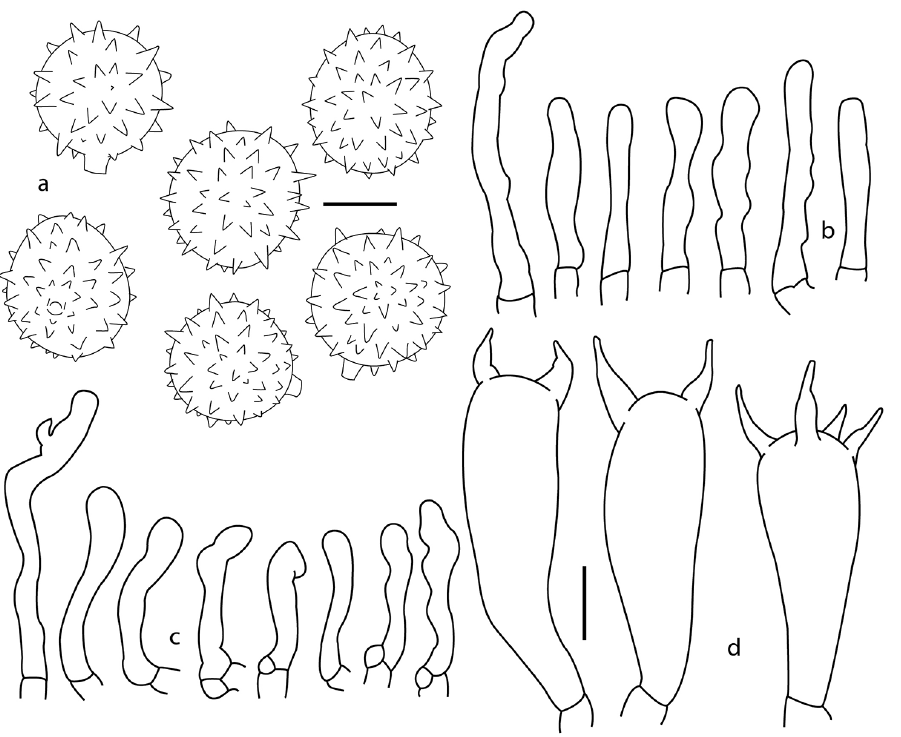
Figure 4. Laccaria squarrosa , a basidiospores b pleurocystidia c cheilocystidia d basidia a, c DM 121 b DM 63 (holotype) d DM 93. Scale bars: 5 µm ( a ); 10 µm ( b–d